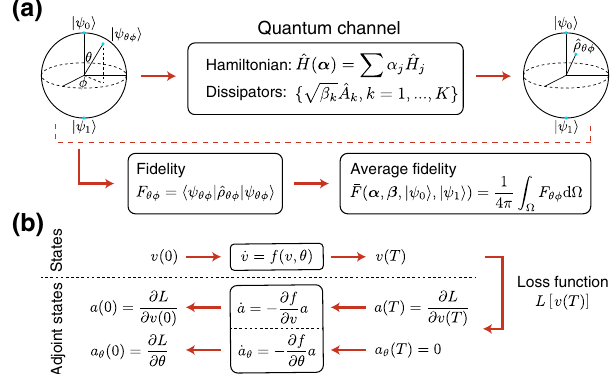
FIG. 1. Schematic of the average fidelity and the adjoint (cid:3) (cid:4) (cid:3) ψ on the Bloch sphere is method. (a) An arbitrary state θφ mapped to a density matrix ˆ ρ θφ by a quantum channel described by a set of control Hamiltonians and dissipators. Averaging the single-state fidelity F θφ over the Bloch sphere gives the average fidelity ¯ F . (b) A loss function L [ v( T ) ] depending on the final state v( T ) of an ODE will implicitly be a function of the initial state v( 0 ) and the ODE parameter θ . The gradients of L with respect to v( 0 ) and θ can be computed by integrating the adjoint equations backward in